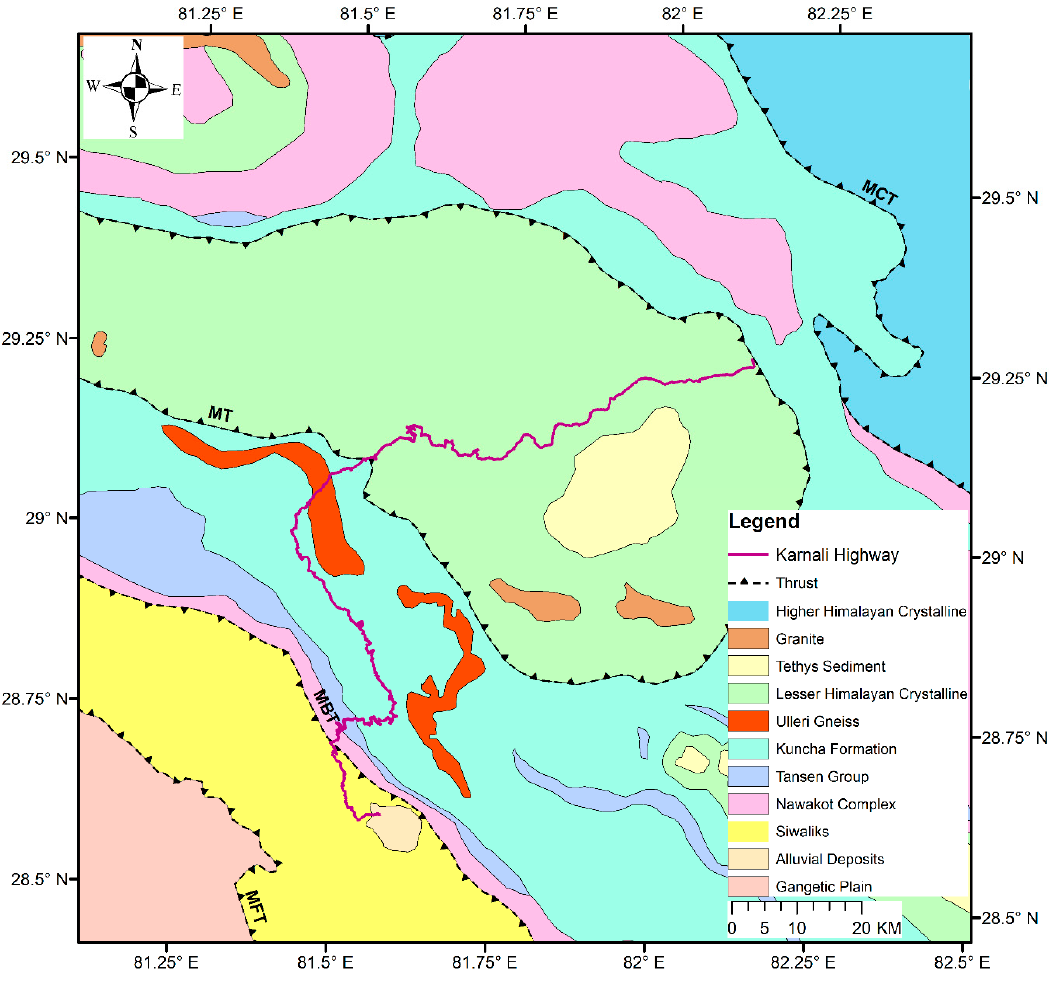
Figure 2. Geologic map of the study area [67] with major thrust faults: Main Frontal Thrust (MFT), Main Boundary Thrust (MBT), Mahabharat Thrust (MT) and Main Central Thrust (MCT).